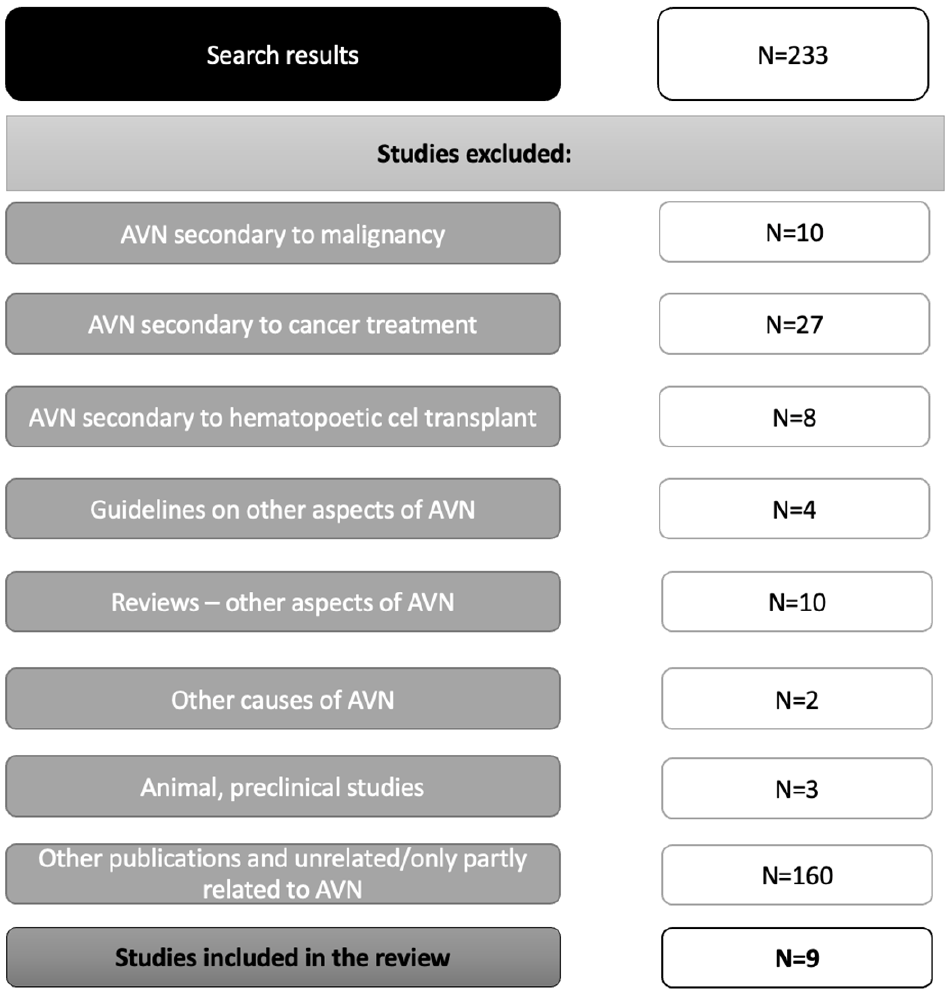
Figure 1. Review of the literature flow diagram of PubMed publications. AVN—avascular necrosis.